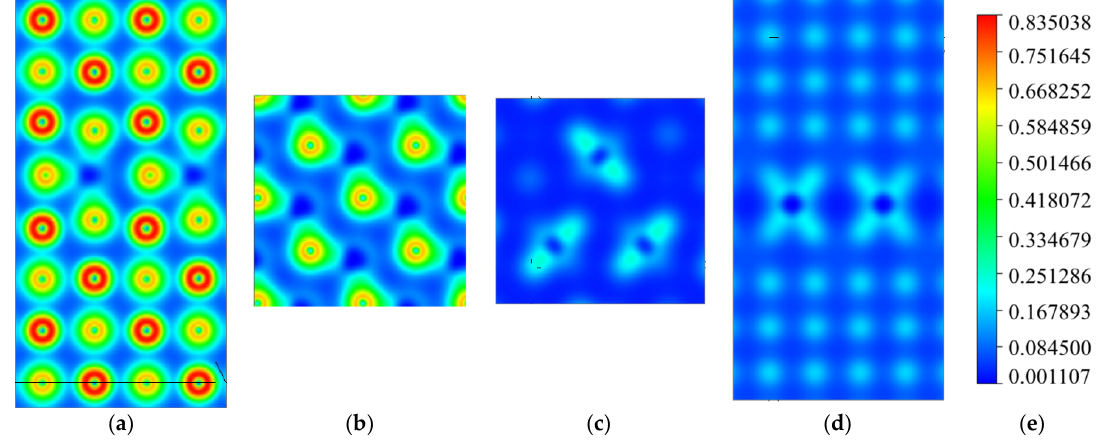
Figure 4. The charge–density of interfaces in nanocomposite structural Ti–Si–N films: ( a ) the front view of the substitution interface; ( b ) the top view of the substitution interface; ( c ) the top view of the interstitial interface; ( d ) the front view of the interstitial interface; and ( e ) the scale of charge density (e ∙ nm − 2 ).